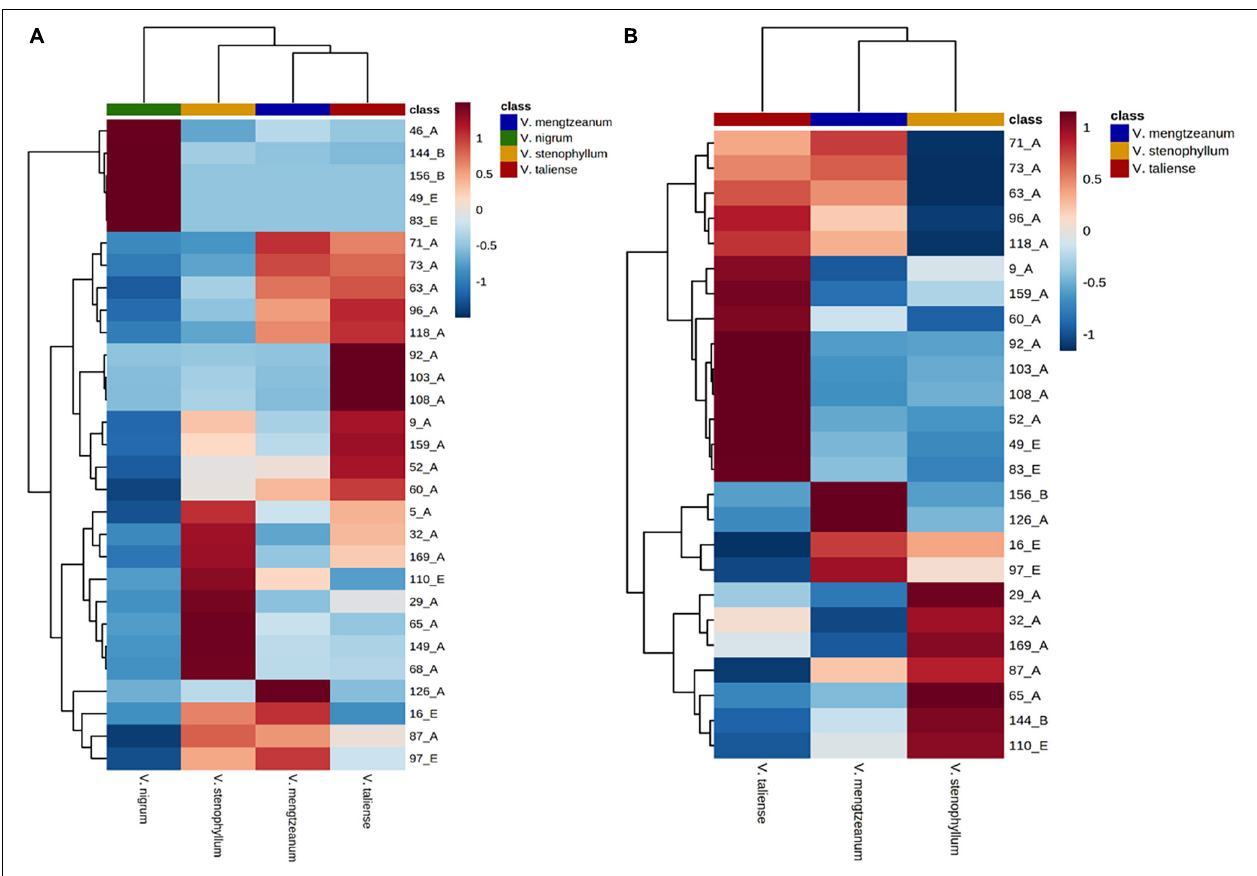
FIGURE 6 | Hierarchical clustering heatmaps of selected variables. Each colored cell on the map corresponds to a concentration value. (A) The selected 29 variables could be used for the identification the origin plants of Pimacao. (B) The selected 25 variables could be used for the identification of V. taliense , V. stenophyllum , and V. mengtzeanum